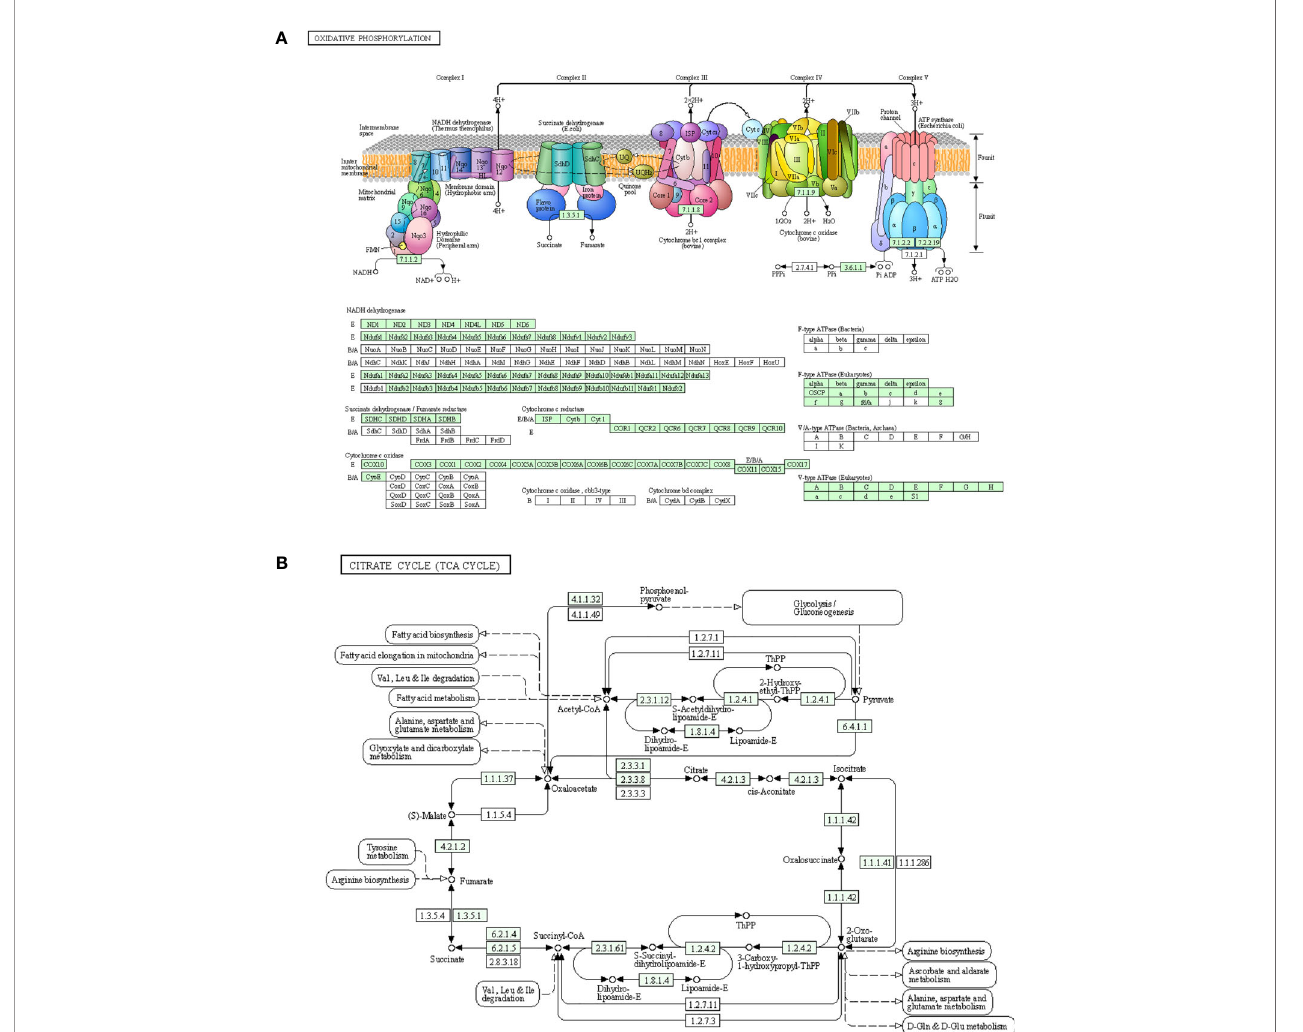
FIGURE 5 | Down-regulated genes in the process of oxidative phosphorylation and the tricarboxylic acid cycle. (A) Genes involved in the oxidative phosphorylation pathway. (B) Genes involved in the citric acid cycle pathway. The newly discovered down-regulated genes after three days of interleukin-6 infusion are marked in green. ATP, adenosine triphosphate; TCA, tricarboxylic acid